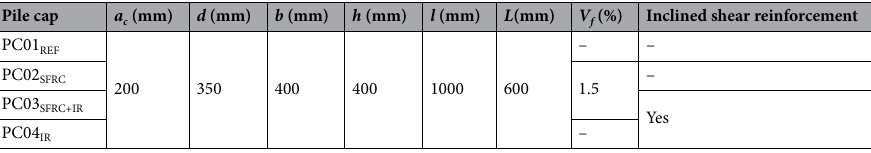
Table 5. General characteristics of the pile caps. NOTE: REF = reference (plain concrete); SFRC = steel fiber reinforcement concrete; and IR = inclined reinforcement.